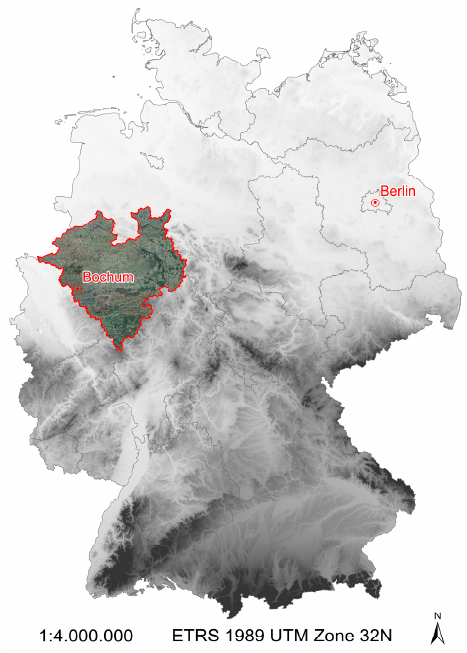
Figure 1. Location of Westphalia (red) in Germany along with the cities of Bochum and Berlin for reference. Data source: SRTM & [13].